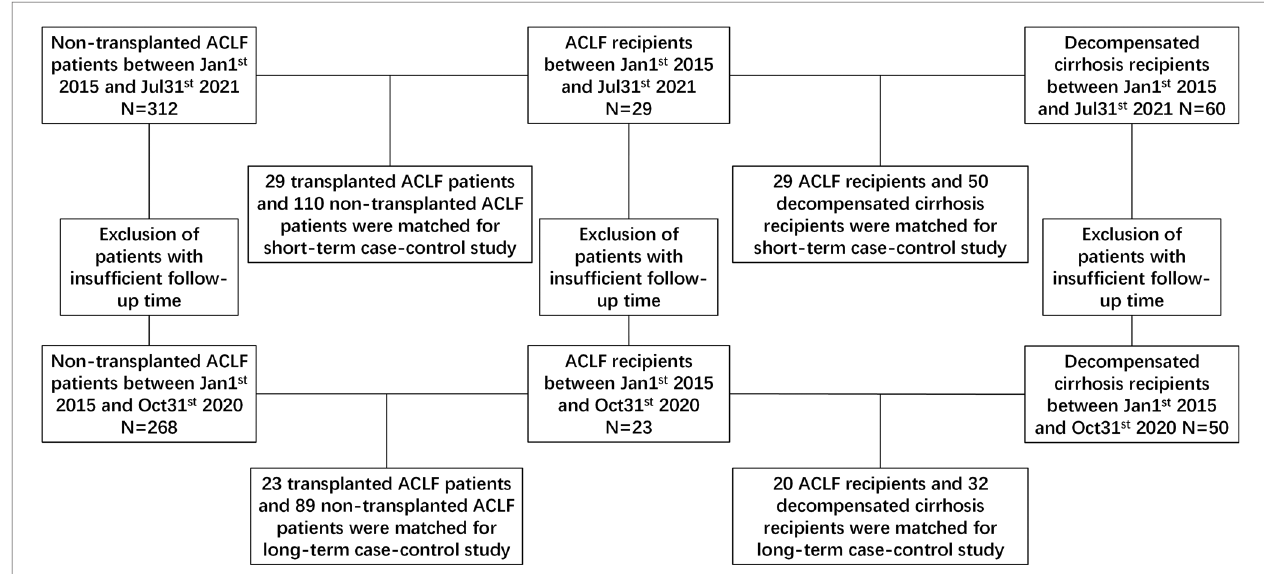
FIGURE 1 | Flowchart illustrates the patients identi fi ed in this